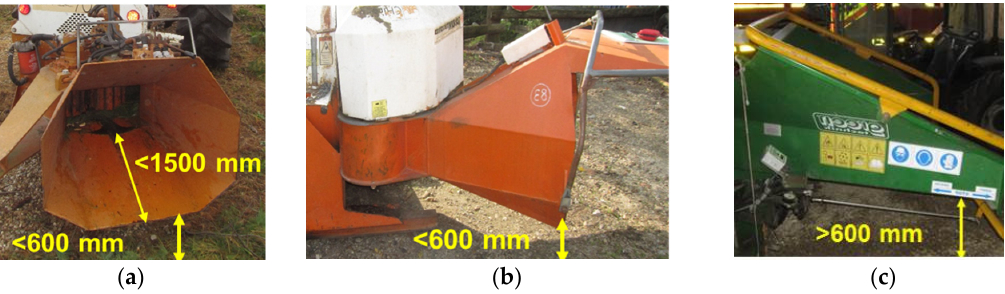
Figure 5. Case studies of infeed chute of in ‐ use wood chippers. Following onsite measurements,